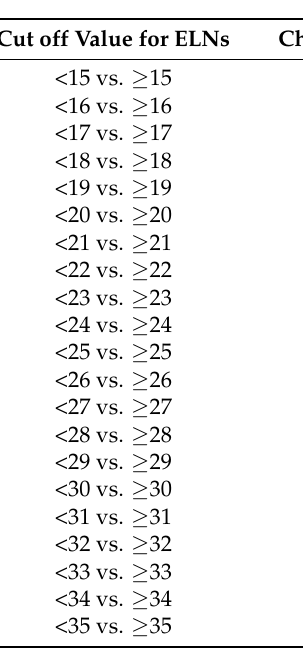
Figure 2. Kaplan–Meier survival curves for overall survival in patients with ELNs < 32 and ELNs ≥ 32. ELNs, examined lymph nodes. Table 2. Analysis of the cutoff value for